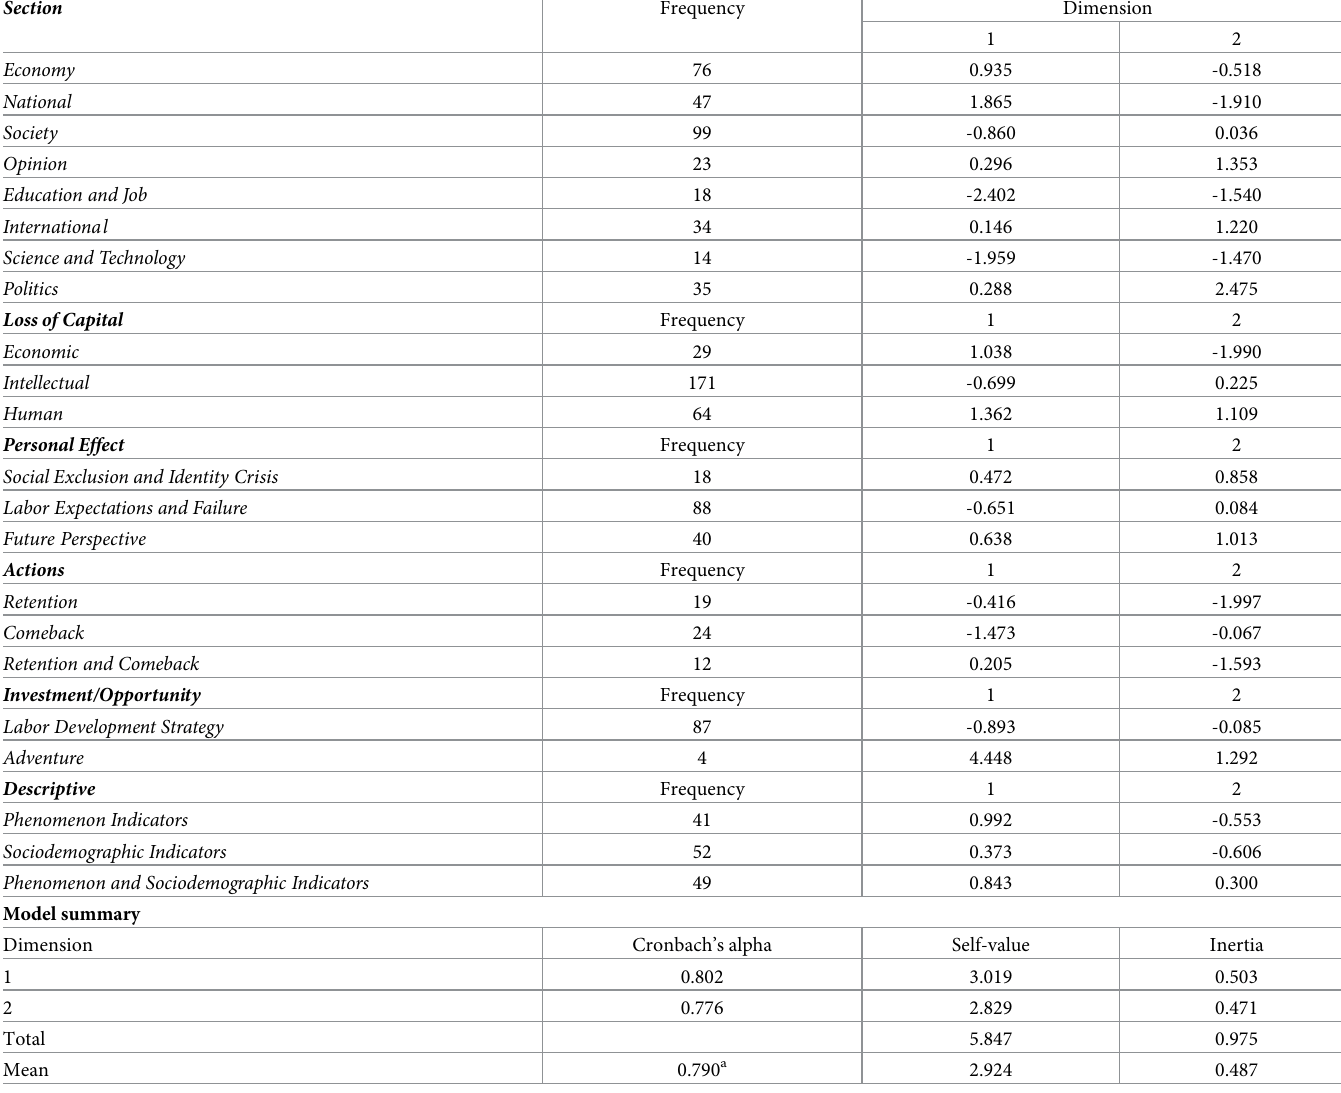
Table 13. Correspondence coordinates between assessment of the phenomenon and